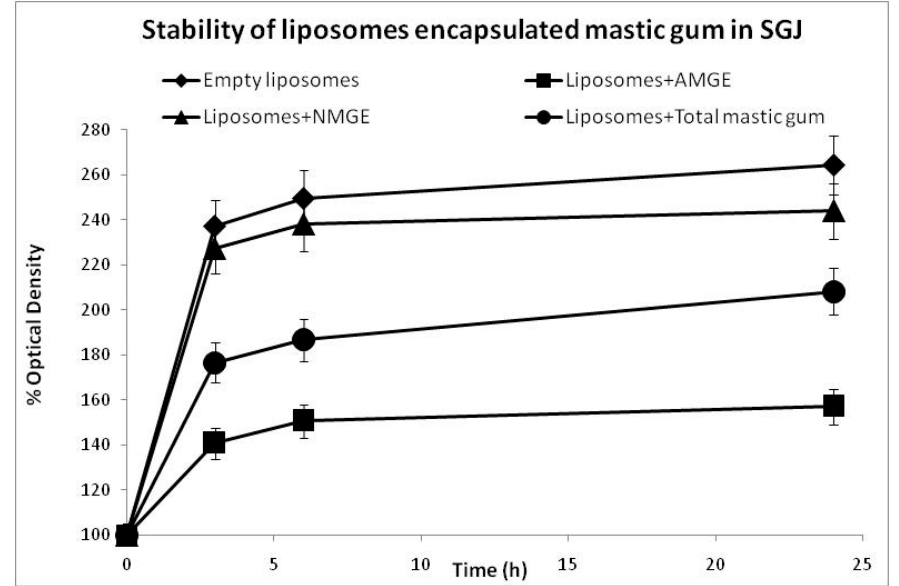
Figure 1. Stability of liposomes encapsulated mastic gum extracts in SGJ (simulated gastric juices ). AMGE: acidic mastic gum extract; NMGE: neutral mastic gum extract.